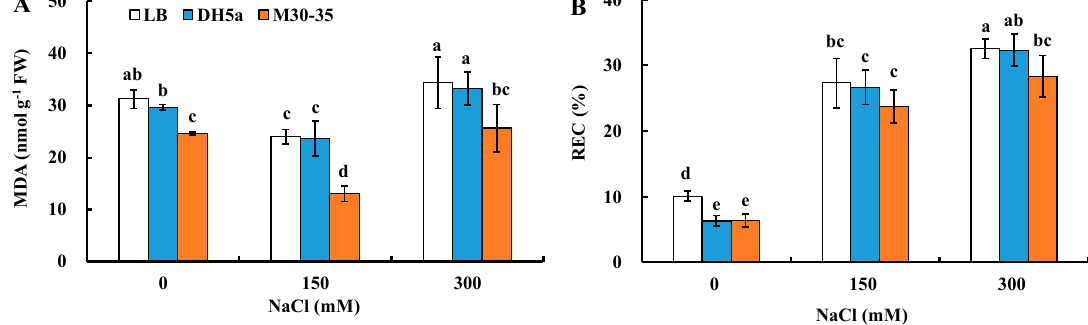
Figure 5. Effects of M30-35 on leaf malonyldialdehyde (MDA) content ( A ) and relative electric conductivity (REC) ( B ) of ryegrass under various salt treatments (0, 150 and 300 mM NaCl). Values are means and bars indicate SEs ( n = 12). Columns with different letters indicate significant differences among treatments at p < 0.05 (ANOVA and Duncan’s multiple comparison test).